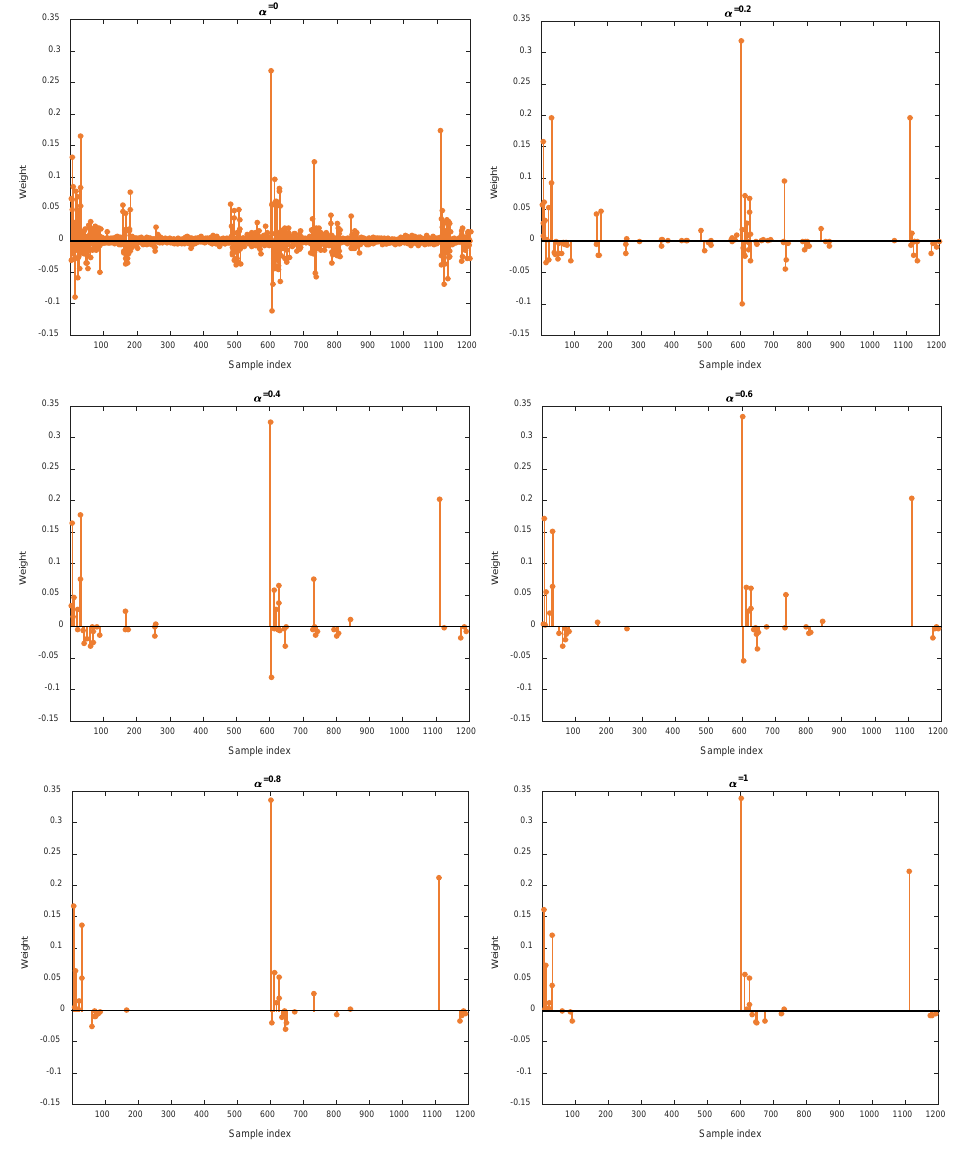
Figure 8. Variation of sparsity w.r.t. different values of